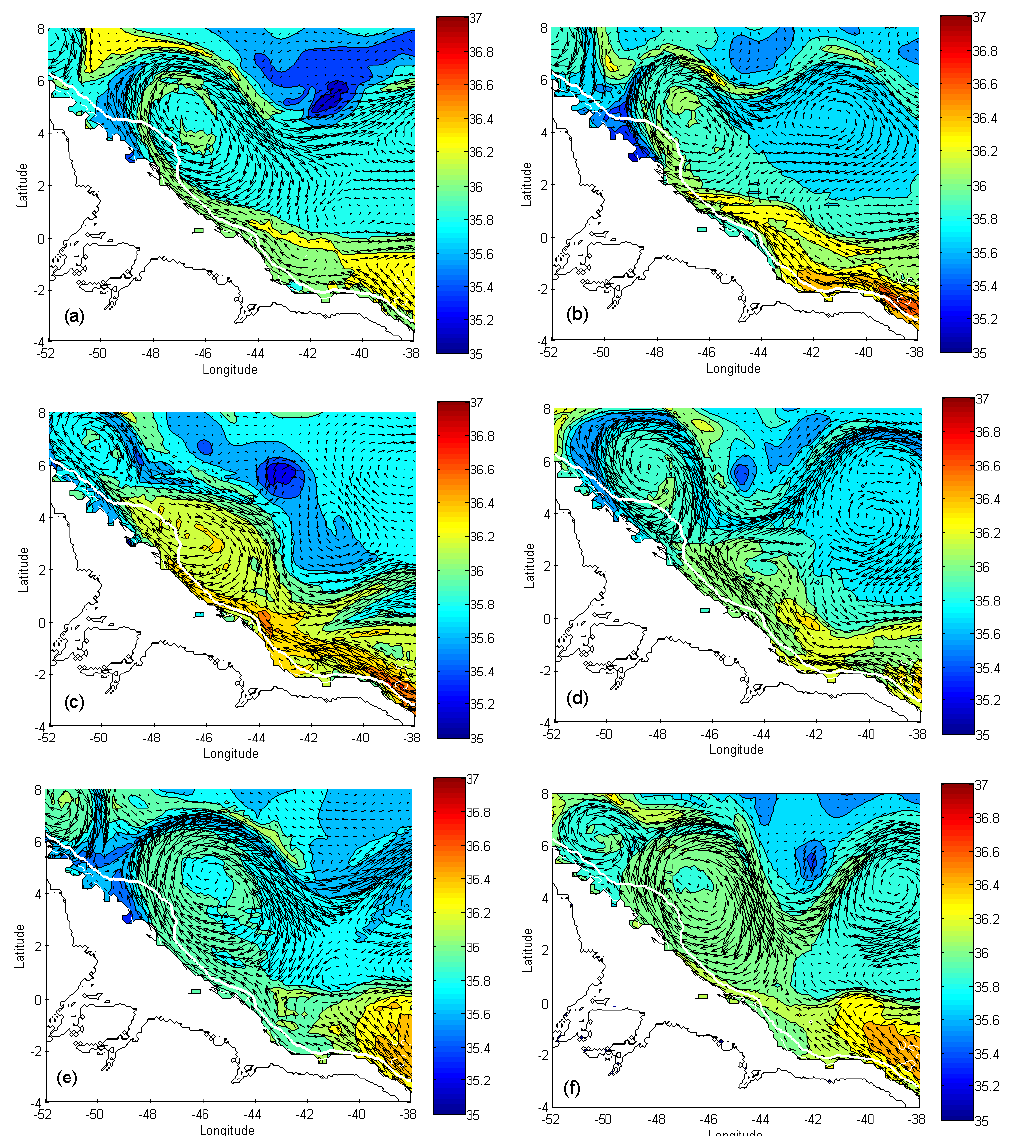
Fig. 5. Seasonal distribution of salinity and velocity from CLIPPER model results at 100m depth for: (a) January 1997, (b) March 1997, (c) May 1997, (d) July 1997, (e) September 1997 and (f) November 1997. Dashed lines represent the isobath